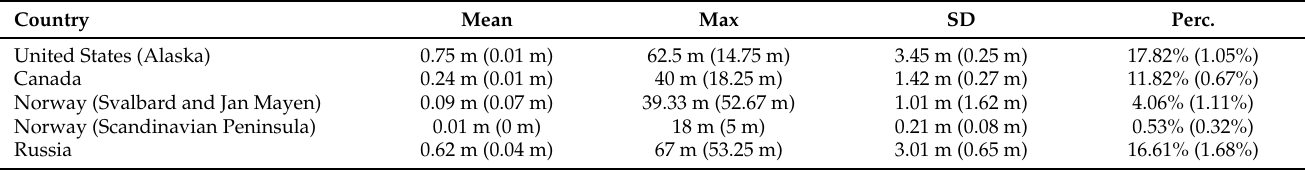
Table 4. Change Vector Analysis (CVA)-based annual erosion and build-up statistics per country and based on 400 m segments. The average, maximum, and the standard deviation (sd) are given. In addition, the percentage of segments with coastal change is provided. Build-up statistics are written in parentheses. Statistics are based on all segments, including segments with no coastal change. Max SD